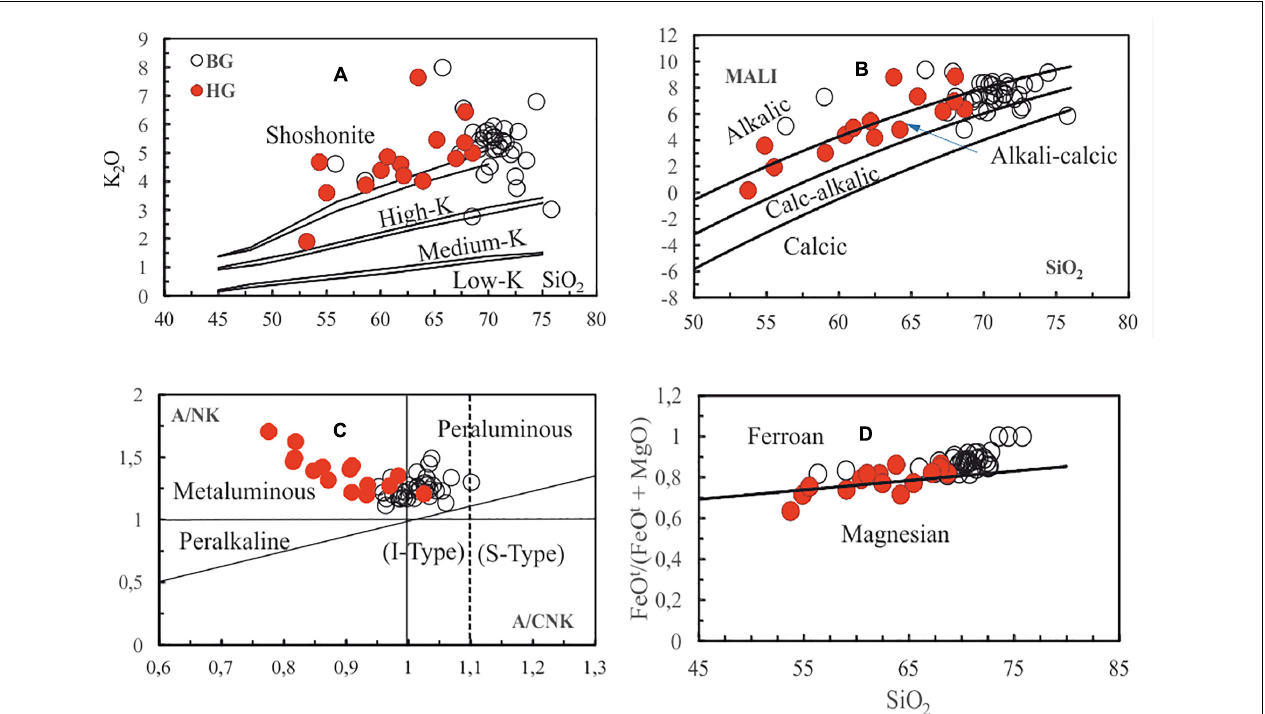
FIGURE 4 | Nature of Batié granites. (A) K 2 O vs. SiO 2 diagram after Peccerillo and Taylor (1976), showing the high-K calc-alkaline to shoshonitic affinity of the Batié granites; boundary lines (bands) are from Rickwood (1989). (B,D) MALI (K 2 O + Na 2 O–CaO vs. SiO 2 ) and FeO* vs. SiO 2 diagrams from Frost et al. (2001), showing the alkali-calcic and ferroan character of the Batié granites. (C) [A/NK (Al 2 O 3 /Na 2 O + K 2 O) vs. A/CNK (Al 2 O 3 /CaO + N 2 O + K 2 O) molecular ratios] diagram after Maniar and Piccoli